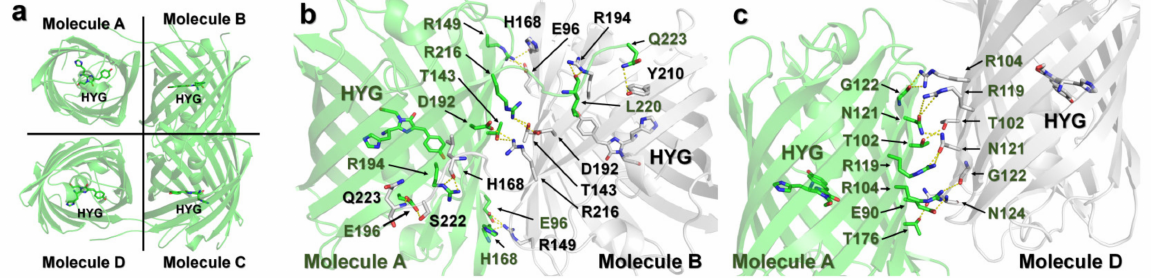
Figure 8. Crystal structure of the green state of DendFP (PDB code 7DIG). ( a ) DendFP forms the tetrameric formation, indicating that the quenchable metal ion could interact with the surface of the tetrameric assembly of DendFP. ( b , c ) Interface of the DendFP monomer in the tetrameric assembly showed no space for metal binding and access to metal chelator. Original figures were obtained from a previous study